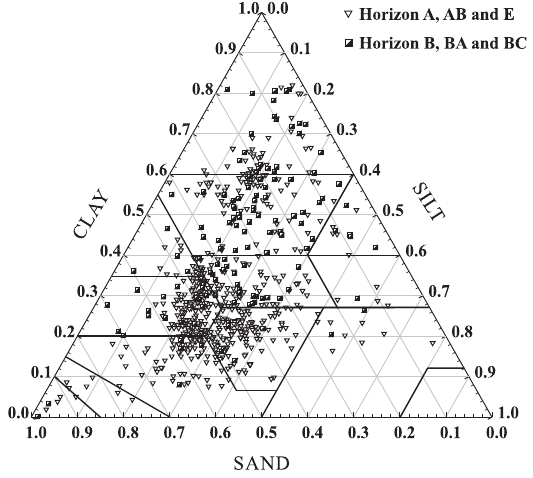
Figure 1. Soil textural classification used for derivation of the